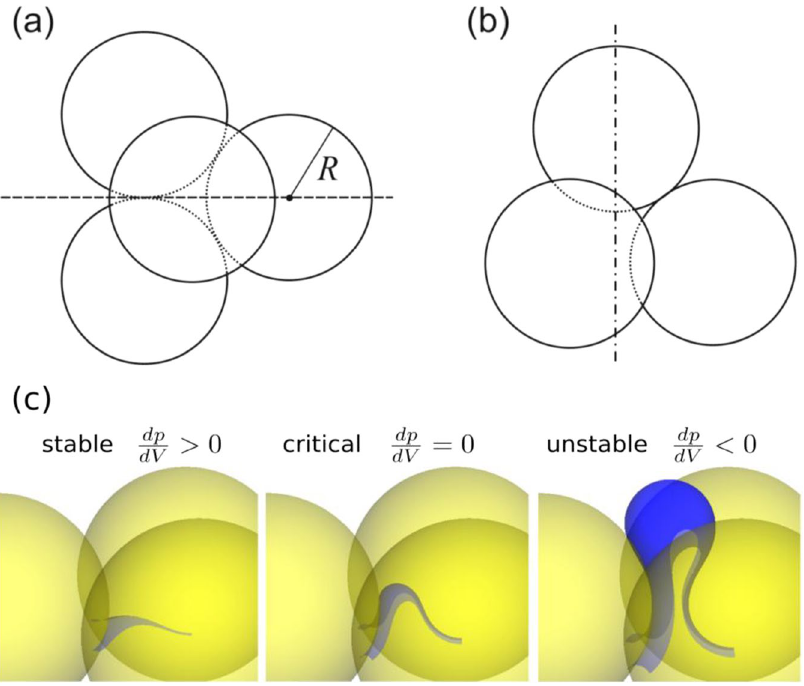
Figure 3. Sketch of a tetrahedral arrangement of spheres, as it frequently appears in random piles of spherical particles. ( a ) Top view and ( b ) Side view: The dash-dotted line indicates one of the four symmetry axes of the tetrahedron for rotations by 120°. The lower left circle represents two spheres one of which eclipses the other. The fluid interface invades from below. ( c ) Sequence of numerically computed constant mean curvature surfaces in a perfect triangular throat for a contact angle of θ = 170°. The image in the middle shows a critical meniscus, i.e. at the point of its largest Laplace